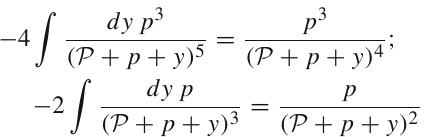
de Sitter vacuum. Remarkably is that the total probability depends only on the ratio M Z /ω . Let us study the behaviour of the total probability in terms of the parameter M Z /ω by a graphical